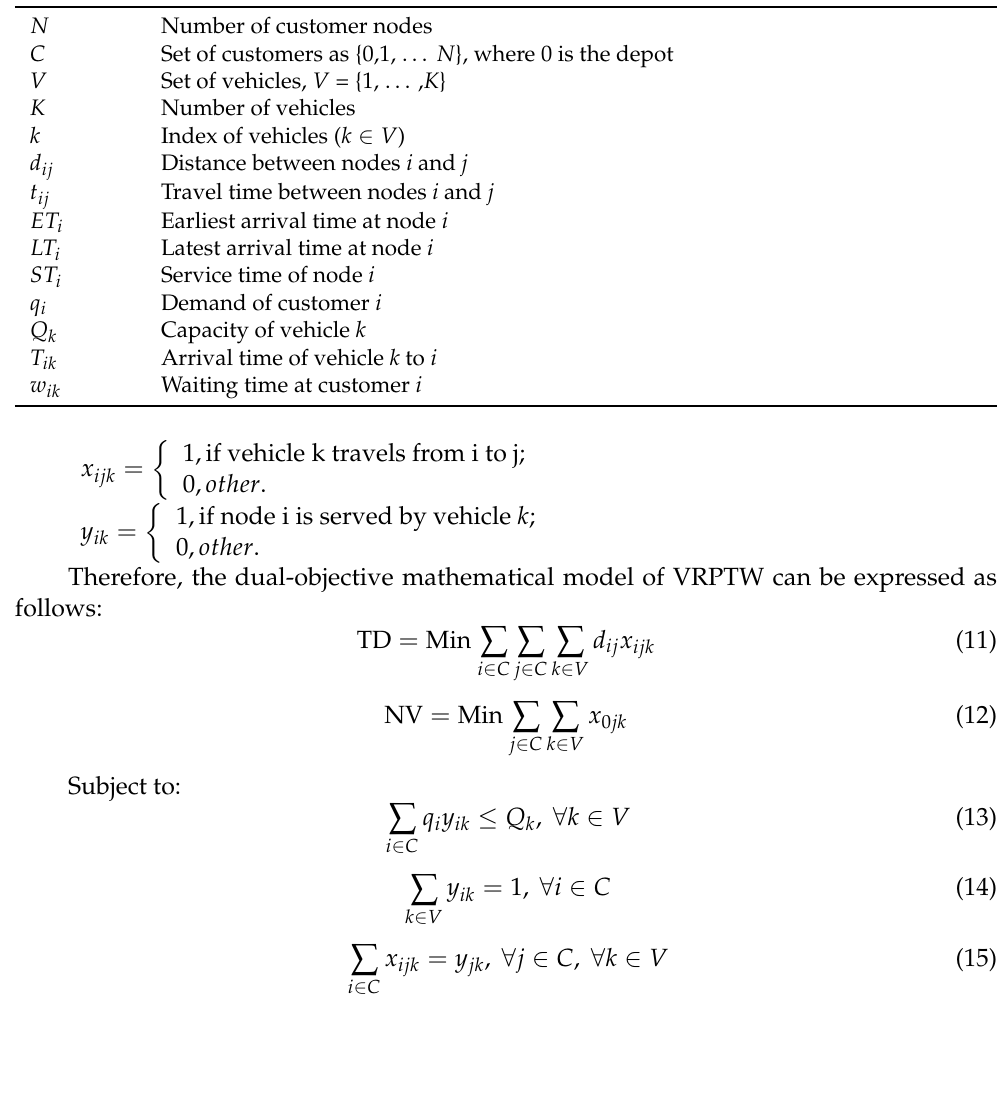
Figure 2. Routes of VRPTW, different colors denote the different routes, circles denotes the customers in these routes, and the arrows denotes the routes. Table 1. Notations and their